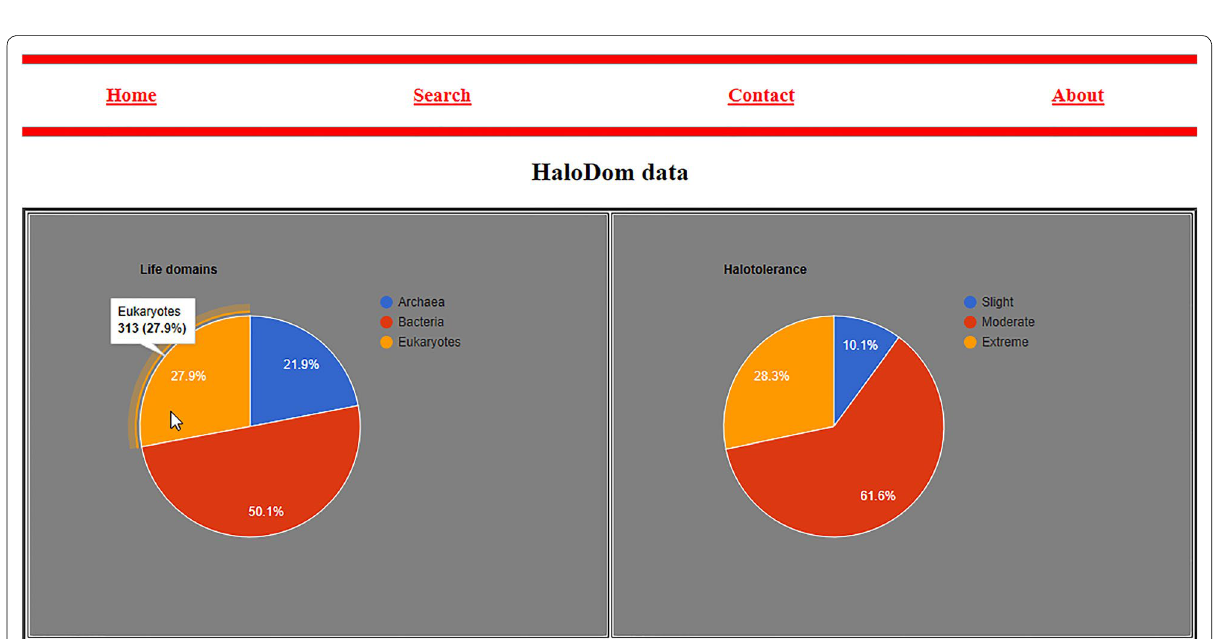
Fig. 6 Halophilic data pie charts. On the left side: frequency and percentage of Archaea, Bacteria and Eukaryotes. On the right side: frequency and percentage of slight, moderate and extreme halophiles in the